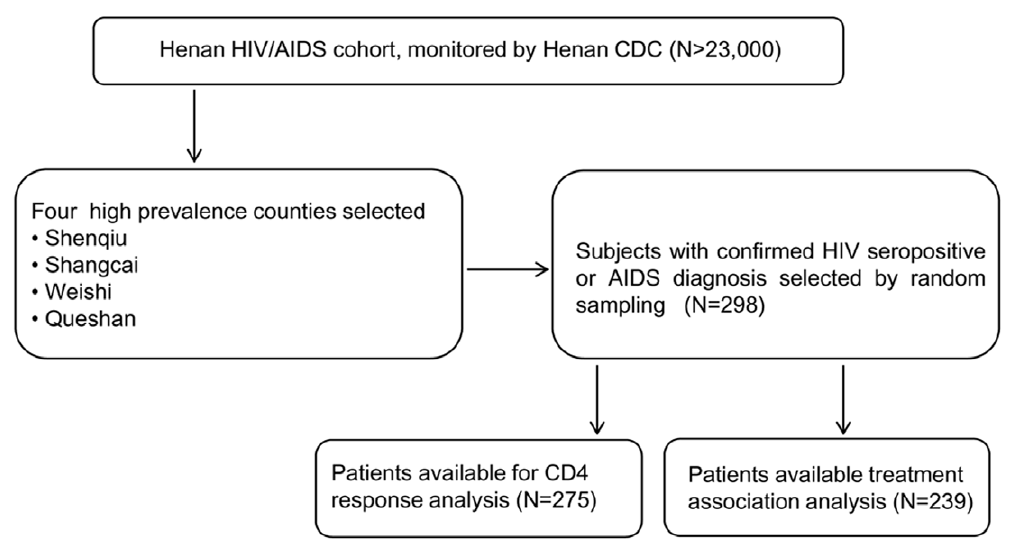
Figure 1. Flow chart of study participant selection.